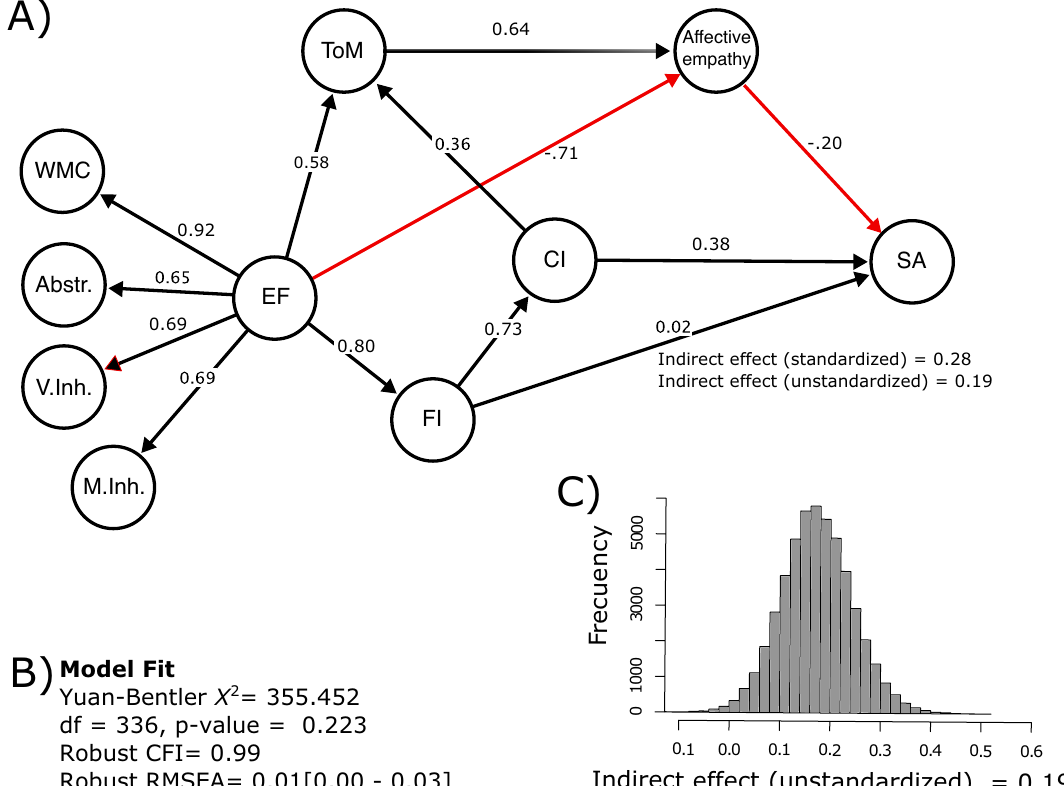
Figure 1. Structural equation modelling social adaptation of vulnerable populations. Main results. ( A ) Structural equation model 1; ( B ) Model fit, values in brackets denote 90% confidence intervals; ( C ) Monte Carlo simulations of the distribution of the unstandardized indirect effect of fluid intelligence (FI) on social adaptation (SA) through crystallized intelligence (CI), values in brackets denote 95% confidence intervals. Variables in circles are unobserved (latent) factors explaining observed (manifest) variables (not shown). Arrows indicate the hypothesized pathways with numbers as the standardized regression estimates. Dashed lines indicate that the effects were not statistically significant. WMC working memory capacity, Abstr. Abstraction, V.Inh verbal inhibitory control, M.Inh motor inhibitory control, EF executive function, ToM theory of mind, FI fluid intelligence, AE affective empathy, SA social adaptation, M marginal